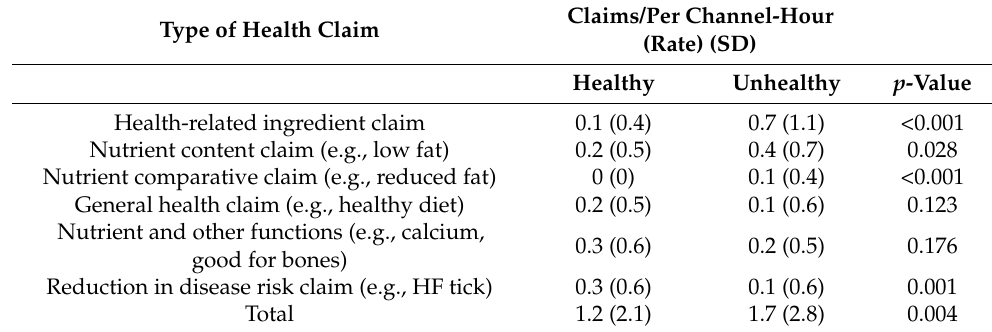
Table 5. Mean rates of health